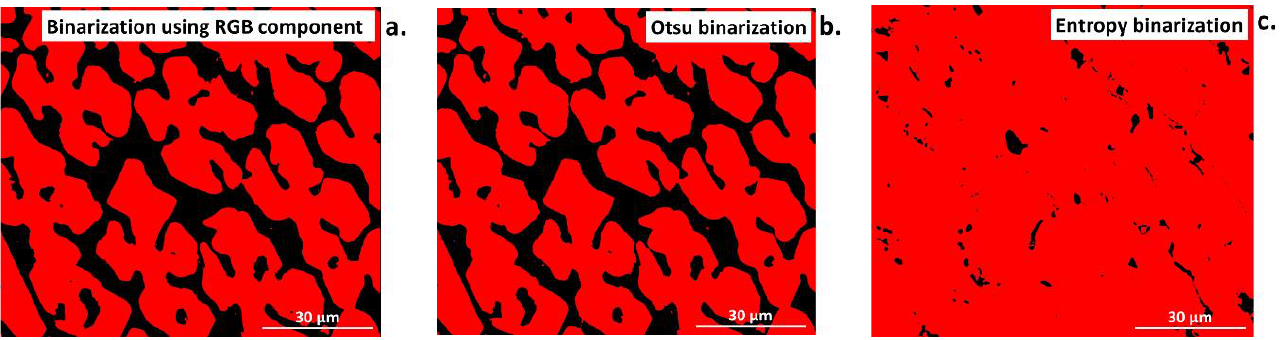
Figure 9. Comparison of various binarization methods, ( a ) using the blue component for RGB, and using automatic threshold methods ( b ) Otsu, ( c ) entropy.